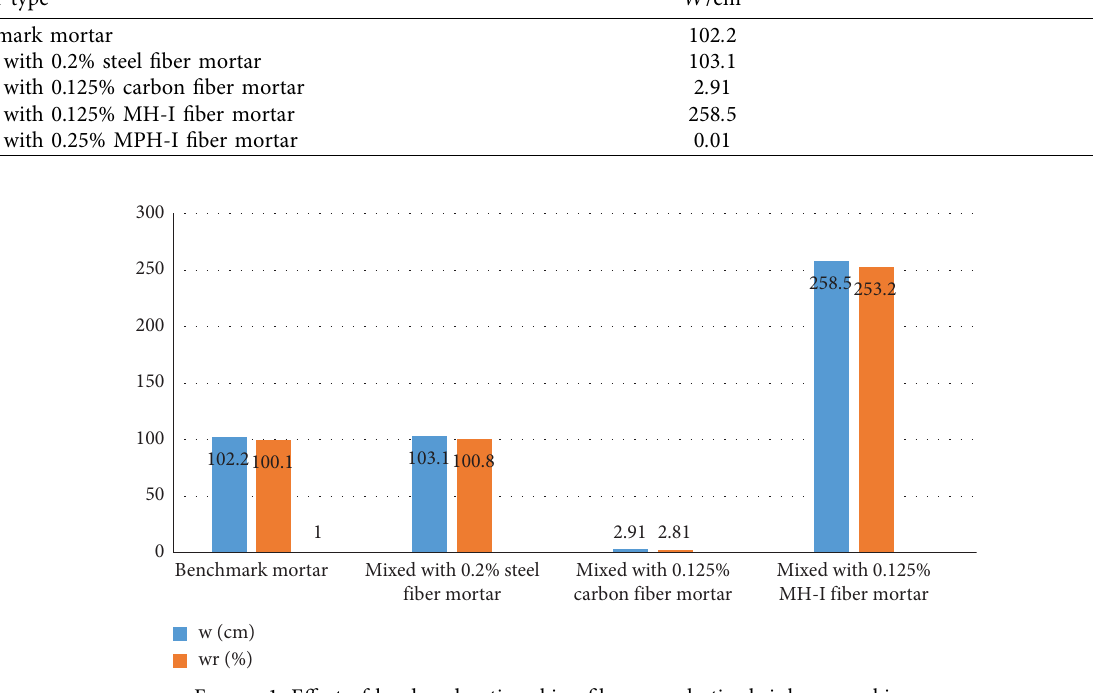
Table 6: Efect of hardened anticracking fbers on plastic shrinkage cracking. Mortar